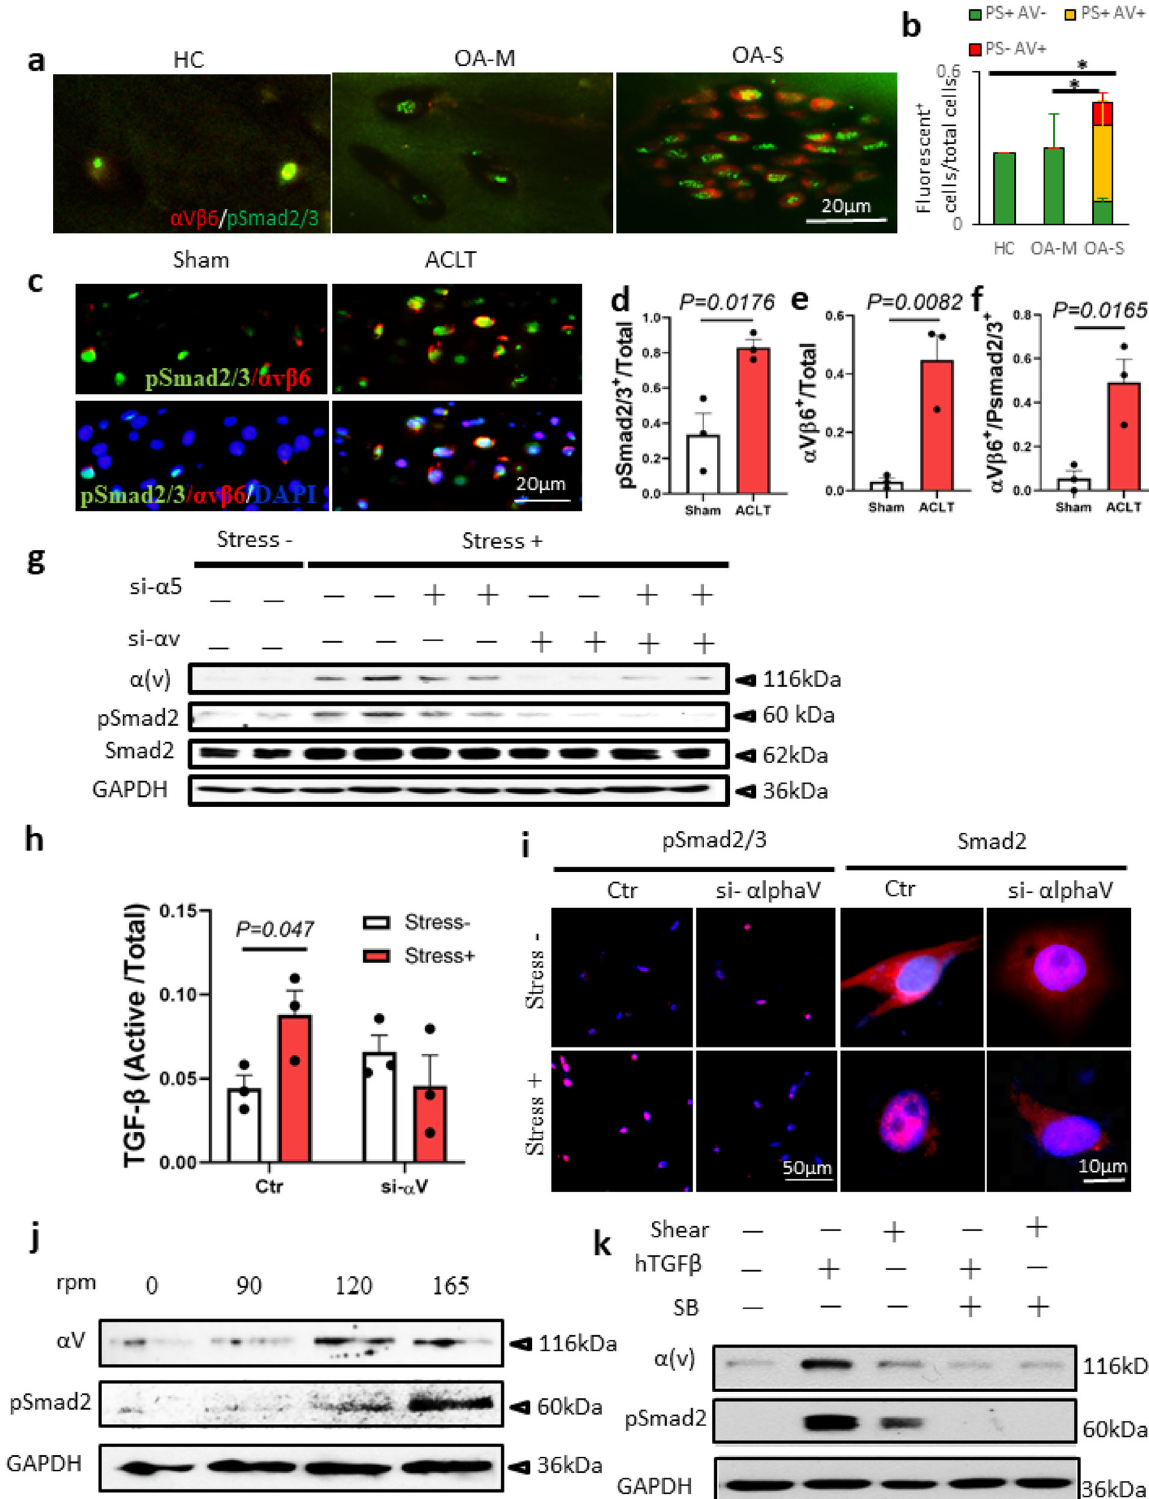
relative to chondrocytes in the shear − group. On the 43-pN TGT surface, the number of remaining chondrocytes in shear + groups was signi fi cantly lower than that of the shear − groups, whereas the talin siRNA-treated shear + group was comparable to the shear − groups. This result indicates that the contractile force that is exerted by most of the chondrocytes in the shear + group